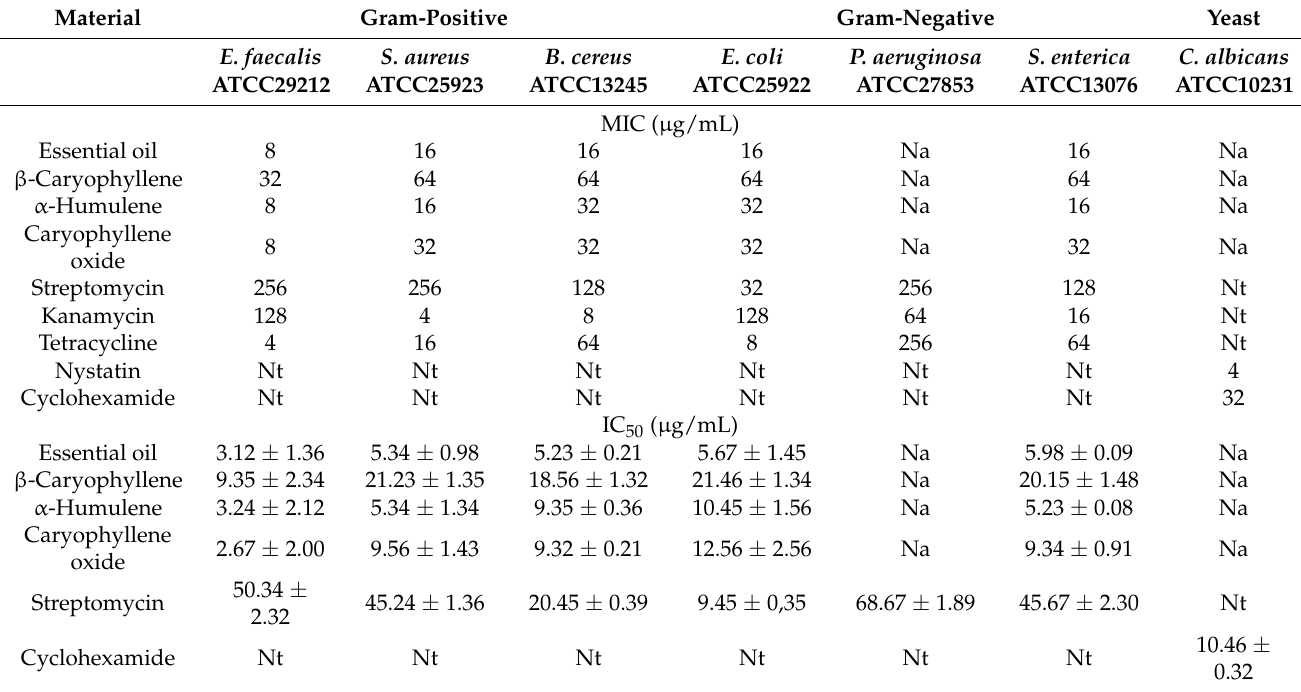
Table 9. Antimicrobial activity of Croton hirtus essential oil and major compounds (MIC, IC 50 , and µ g/mL).